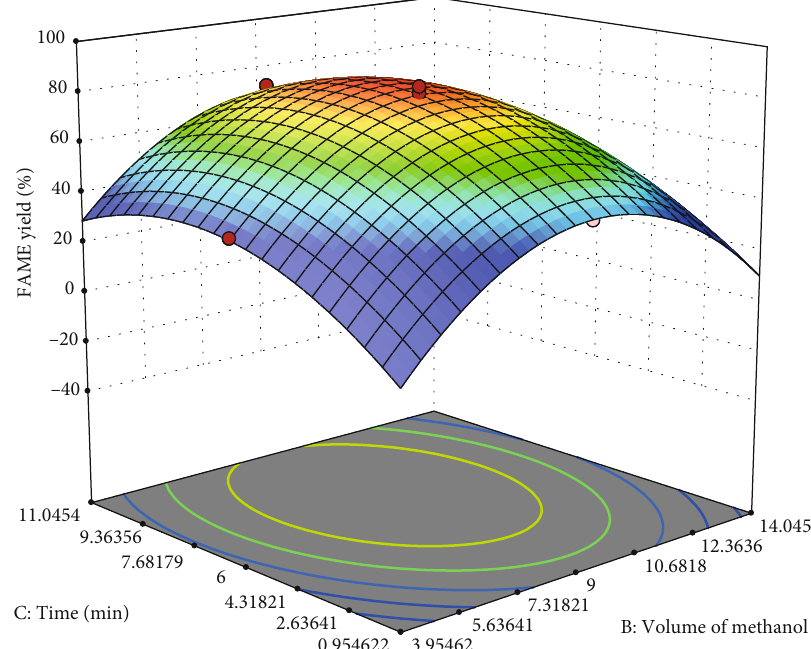
Figure 3: RSM plot: e ff ect of volume of methanol ( CH